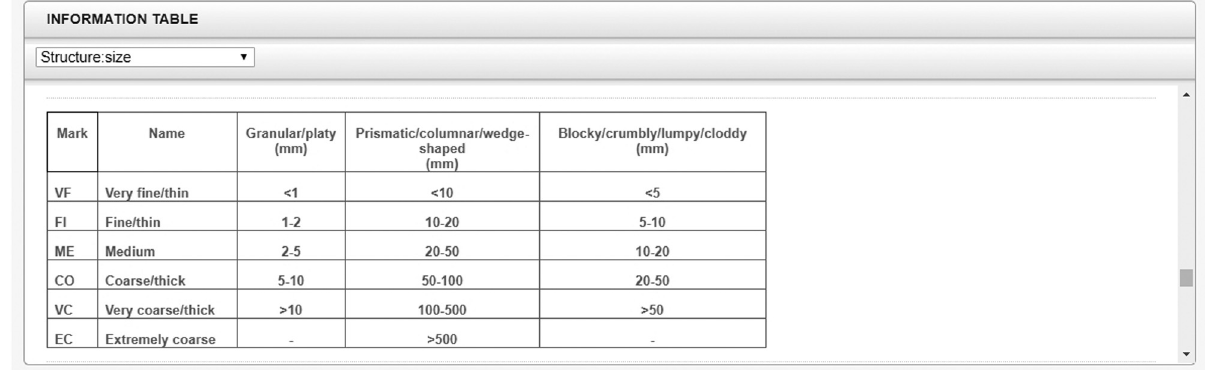
Figure 13: Identi fi cation keys of soil